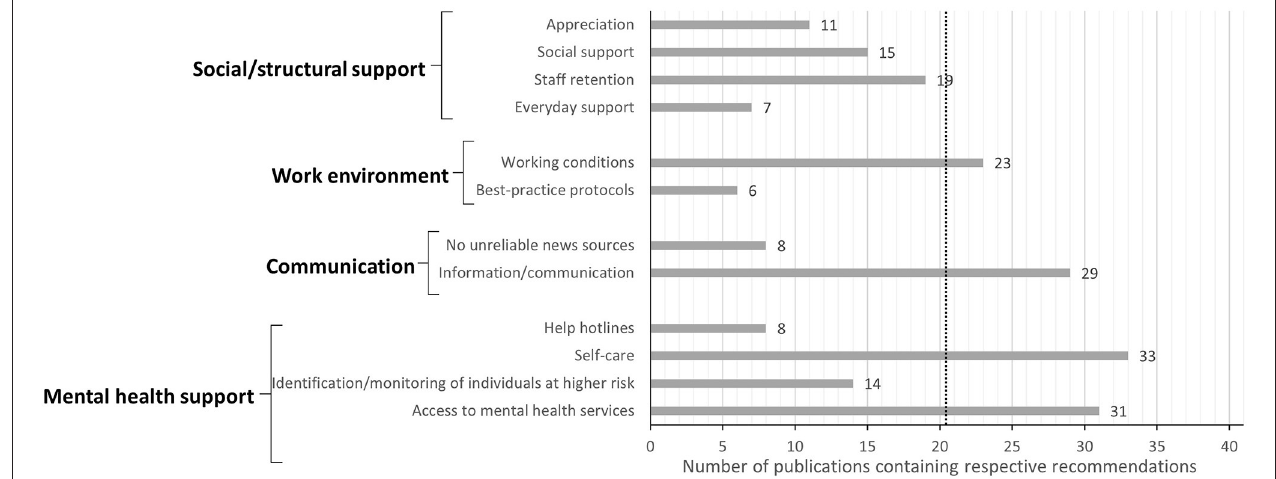
FIGURE 2 | Overview of the types of recommendations given to improve mental health in HCWs during the COVID-19 pandemic. The numbers of publications including each recommendation are displayed. Dotted line displays the threshold of referencing the given topic in ≥ 50% of the included publications. A total of N = 41 publications were